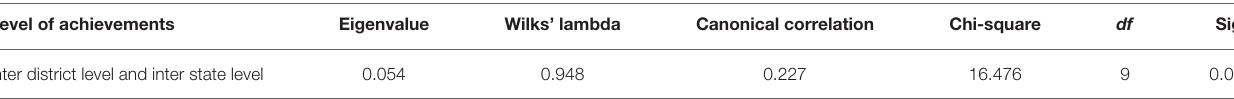
TABLE 5 | Discriminant function analysis showing differences between levels of achievement in dimensions of all factors.